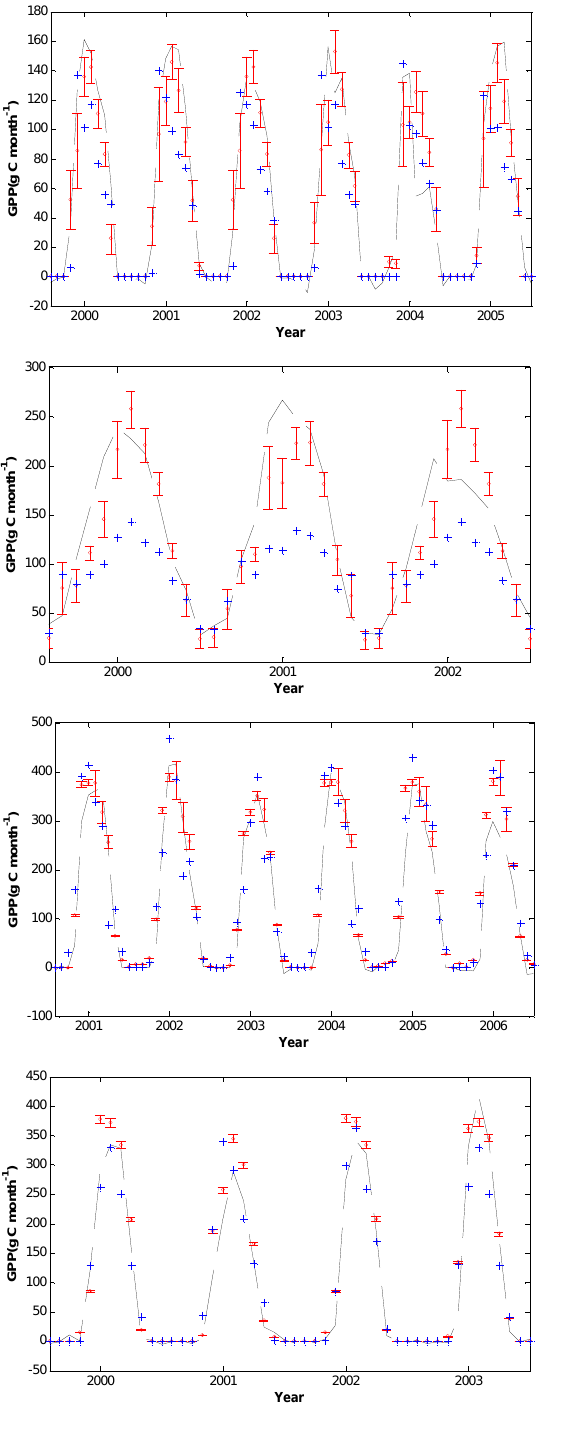
Fig. 3. Comparison of seasonal variations of the observed GPP and NEP with SAT-TEM and TEM predictions at the ten additional AmeriFlux sites. Dashed lines are the observed values while circles and crosses are the predictions with SAT-TEM and TEM, respectively. The error bars indicates the standard deviation of the results by ensemble SAT-TEM simulations with 50 sets of posterior parameters: (a) Niwot Ridge site; (b) Wind River Crane site (c) Morgan Monroe State Forest site; (d) Willow Creek site; (e) Kendall Grassland site; (f) Walnut River site; (g) Sky Oaks Old site; (h) Santa Rita Mesquite Savanna site; (i) Rosemount G21 Conventional Management Corn Soybean Rotation site; (j) Mead Irrigated Rotation